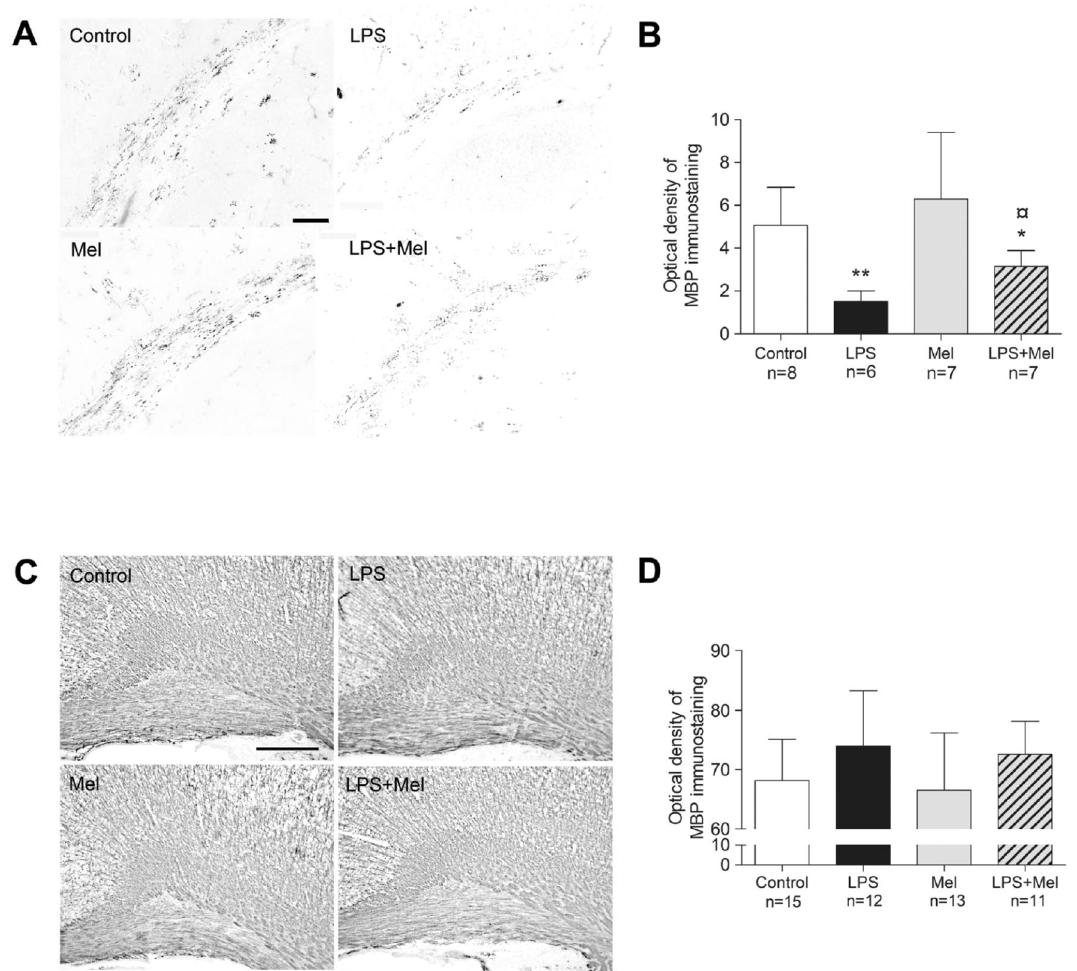
Figure 5. Melatonin did not effectively prevent LPS-induced hypomyelination within the external capsule at PND7. Myelin-basic protein (MBP) stainings were performed at PND7 ( A , B ) and at PND21 ( C , D ). The optical immunodensity of MBP staining was measured within the external capsule at PND7 (magnification 10, scale bar = 100 µm) ( A,B ) and within the cingulum at PND21 (magnification 10, scale bar = 200 µm) ( C , D ). White, black, grey and hatched grey bars represented the Control, the liposaccharide portion of the E.coli membrane (LPS), the melatonin (Mel) and the LPS + Mel groups, respectively. Results are expressed as the mean ± standard deviation. Statistical analysis: One-Way-ANOVA test was performed associated with Bonferroni post-test, * p < 0.05 and ** p < 0.01 in comparison with the control group. ¤ p < 0.05 in comparison with the LPS